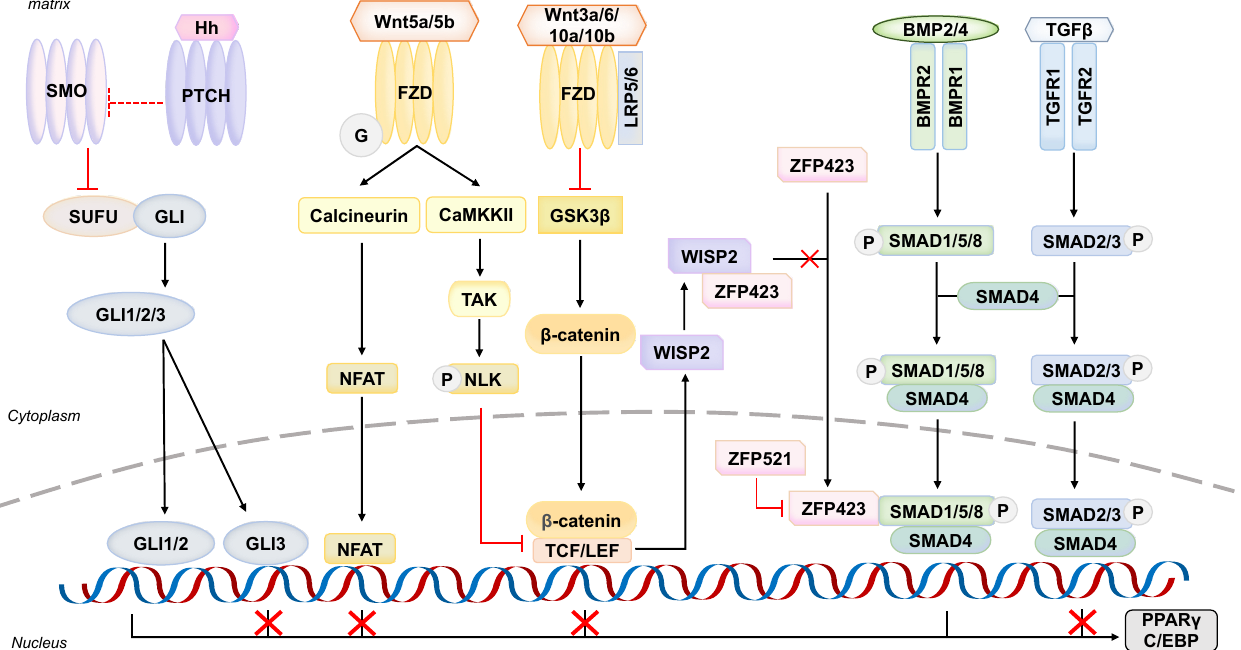
Figure 2. Schematic diagram on BMP, Wnt, and Hh signalling. The mechanism of lineage commitment in ASCs is extensively studied in relation to BMP, Wnt, and Hh signaling. It should be noted that, while BMP signaling pathway is pro-adipogenic and promotes the expression of PPAR γ and C/EBP, the TGF β , Wnt, and Hh signaling pathways are anti-adipogenic (as marked with red cross). As observed in both rodents and obese patients, dysregulation in these pathways restricts the AT expandability and hence promotes the adipocyte hypertrophy. Nevertheless, this also offers a variety of potential therapeutic targets against obesity, by which restoring the adipogenic capacity can maintain the metabolic health and adipocyte